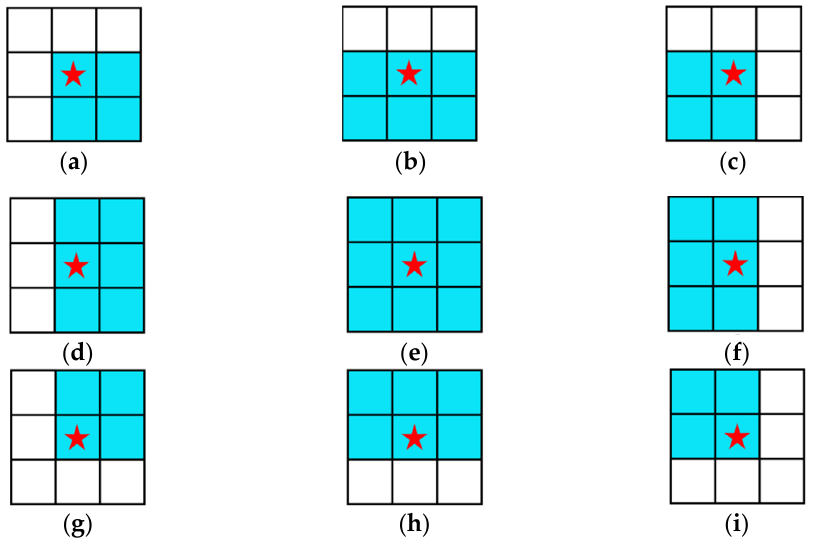
Figure 5. Flow chart of projection texture mapping for a single video image.